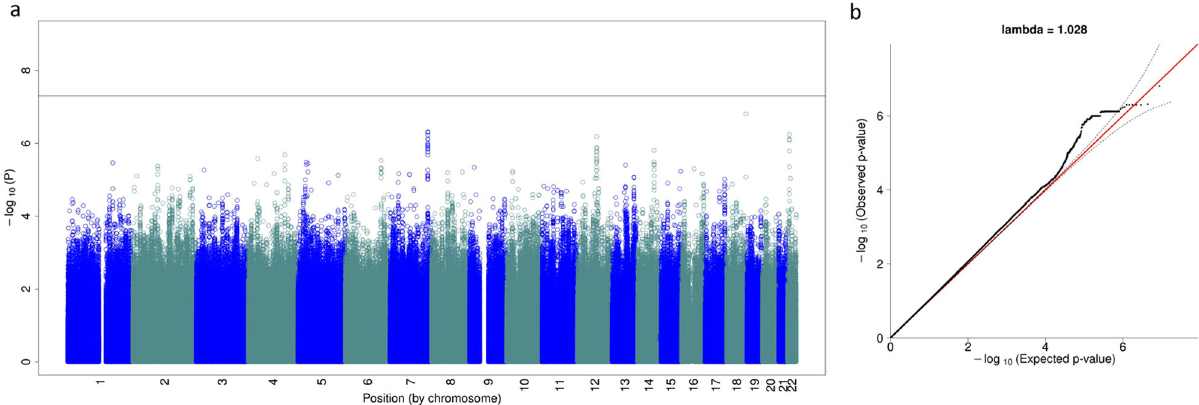
Fig. 3 Meta-analysis results from evaluation for type-I error. The Manhattan plot ( a ) shows the expected no signal, while the QQ-plot ( b ) shows no in fl ation.